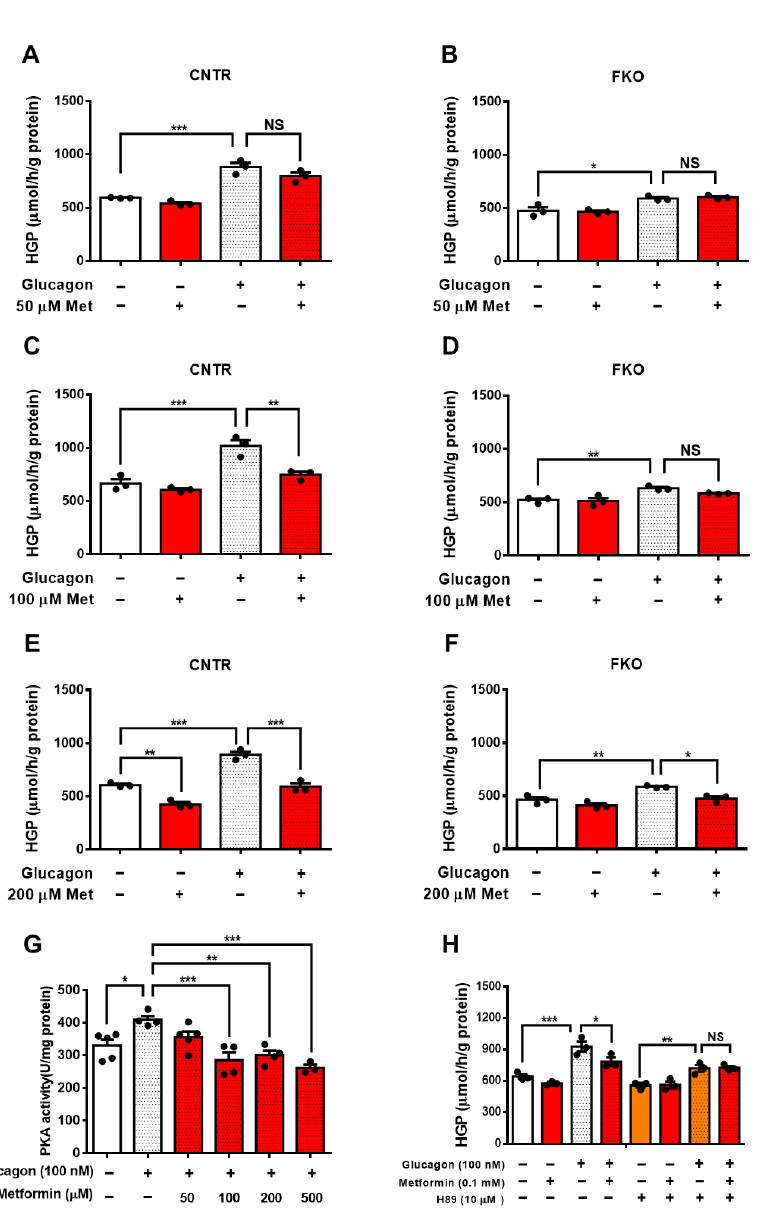
Figure 1. Metformin suppresses glucagon-induced HGP through the PKA–Foxo1 signaling pathway in primary hepatocytes. ( A , B ) Primary hepatocytes isolated from control ( A ) and FKO ( B ) mice were pretreated with 50 µ M of metformin for 30 min and treated with 100 nM of glucagon for 3 h. Glucose content was measured, n = 3 independent experiments/group. ( C , D ) Primary hepatocytes isolated from control ( C ) and FKO ( D ) mice were pretreated with 100 µ M of metformin for 30 min and treated with 100 nM of glucagon for 3 h. Glucose content was measured, n = 3 independent experiments/group. ( E , F ) Primary hepatocytes isolated from control ( E ) and FKO ( F ) mice were pretreated with 200 µ M of metformin for 30 min and treated with 100 nM of glucagon for 3 h. Glucose content was measured, n = 3 independent experiments/group. ( G ) Control hepatocytes were pretreated with 50, 100, 200, and 500 µ M of metformin for 30 min and treated with 100 nM of glucagon for 1 h. PKA activity was analyzed, n = 3–5 independent experiments/group. ( H ) Control hepatocytes were pretreated with H89 and metformin, followed by 100 nM glucagon treatment for 3 h. Glucose content was measured, n = 3 independent experiments/group. All are are presented as mean ± SEM. * p < 0.05, ** p < 0.01, *** p < 0.001, NS: no significance, CNTR: control.